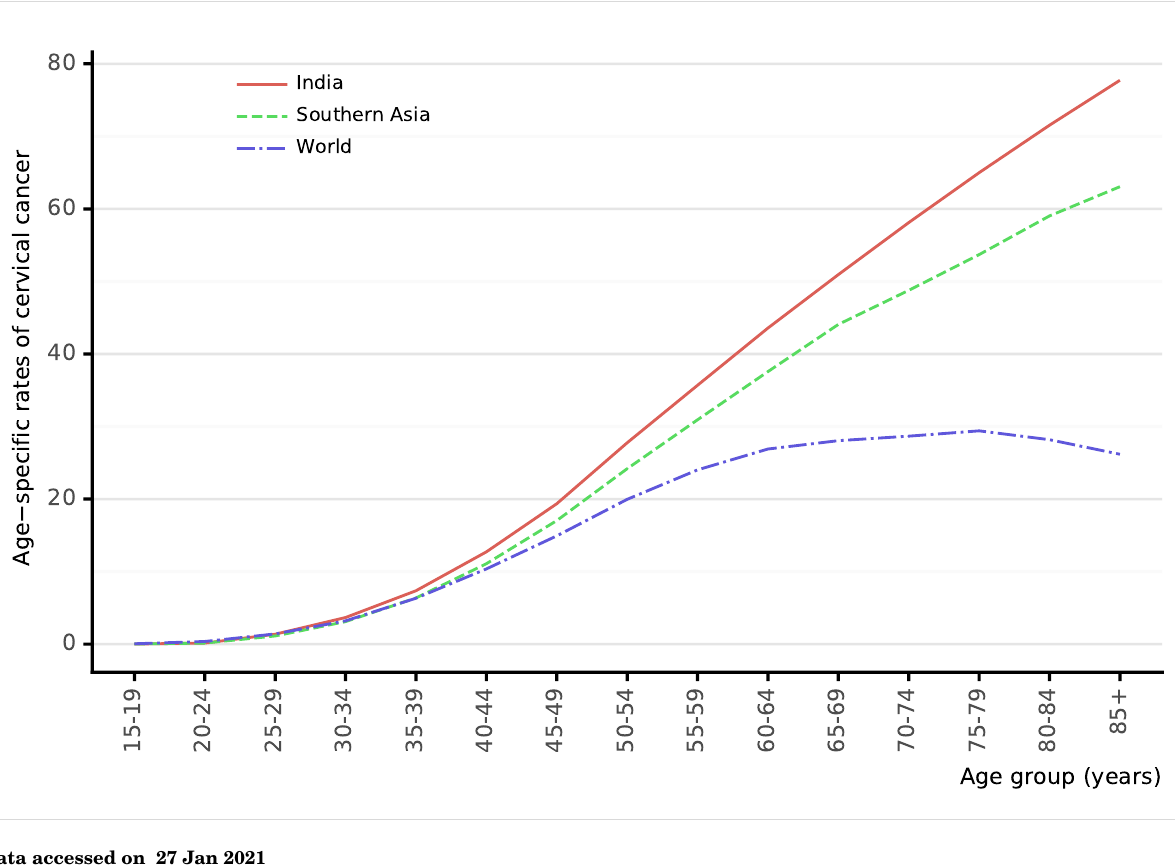
Figure 107: Comparison of age-specific cervical cancer mortality rates in India, within the region, and the rest of